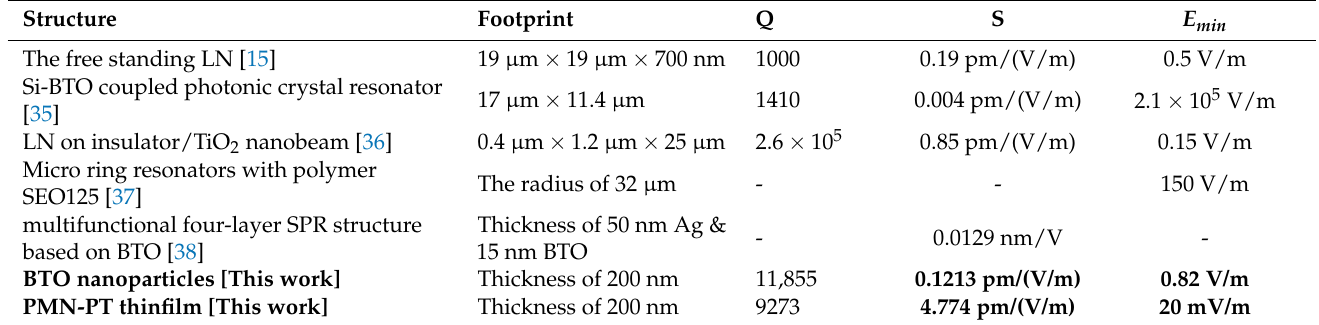
Table 3. Different sensors and comparison of footprint size, operating wavelength, quality factor Q , sensitivity S and the minimum detectable electric field E min